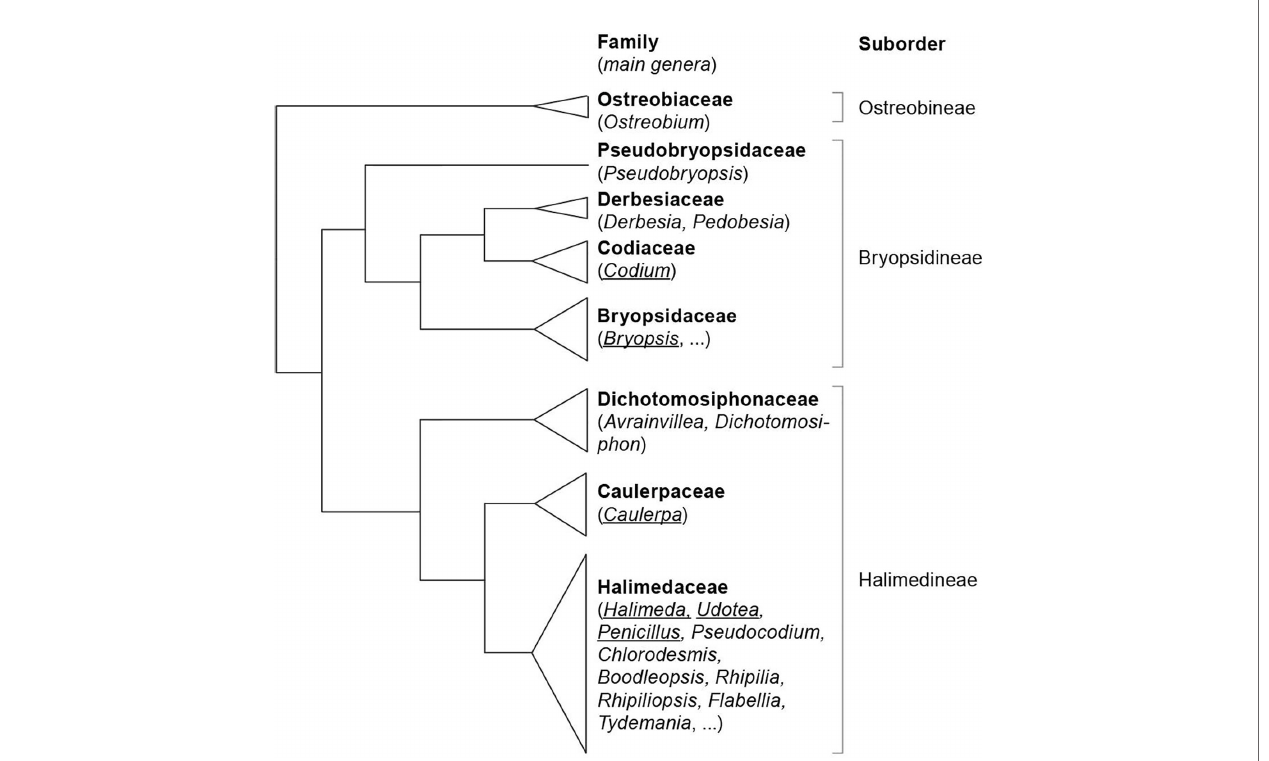
FIGURE 3 | Phylogenetic relationships of the families and suborders of the Bryopsidales (based on Cremen et al., 2019). The genera for which data on sulfated polysaccharides is available, and which are discussed in this review, are